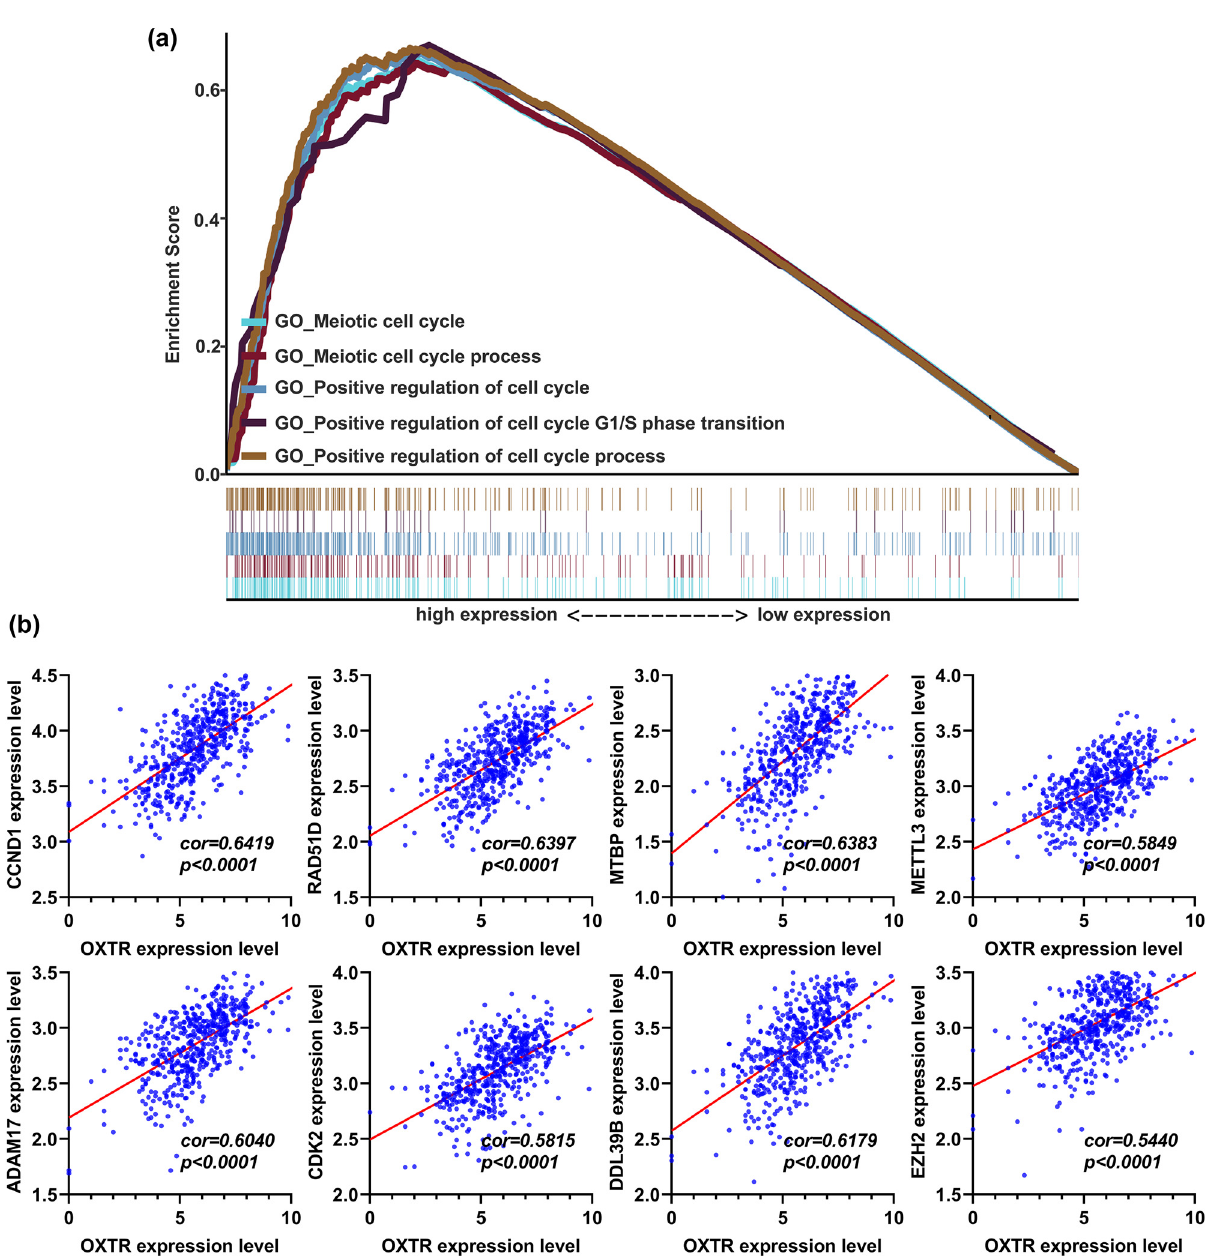
Figure 5: GO enrichment analysis of the correlation between OXTR mRNA level and genes related to cell cycle regulation. ( a ) Gene set enrichment analysis of the correlation between OXTR expression and mRNA levels of genes involved in cell cycle regulation. ( b ) Correlation analysis between OXTR expression and mRNA levels of genes involved in cell cycle regulation. GO, gene